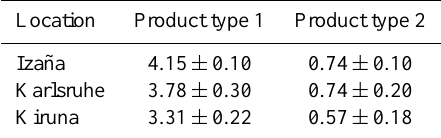
Table 1. Mean and standard deviation of degree of freedom of signal (DOFs) for the two product types and the three